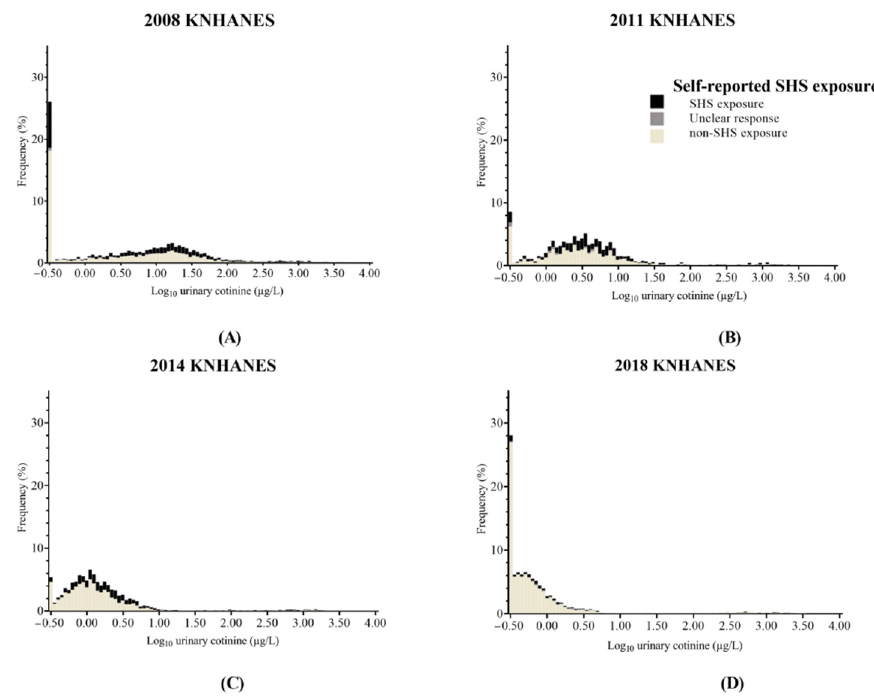
Figure 3. The distributions of urinary cotinine concentration from nonsmokers according to SHS exposure. 2008 KNHANES ( A ), 2011 KNANES ( B ), 2014 KNANES ( C ), and 2018 KNANES ( D ). The black, gray, and ivory boxes represent the percent frequency of SHS exposure, unclear response for SHS exposure, and no SHS exposure, respectively, among nonsmokers. KNHANES = Korean National Health and Nutrition Examination Survey. SHS = second-hand smoke.